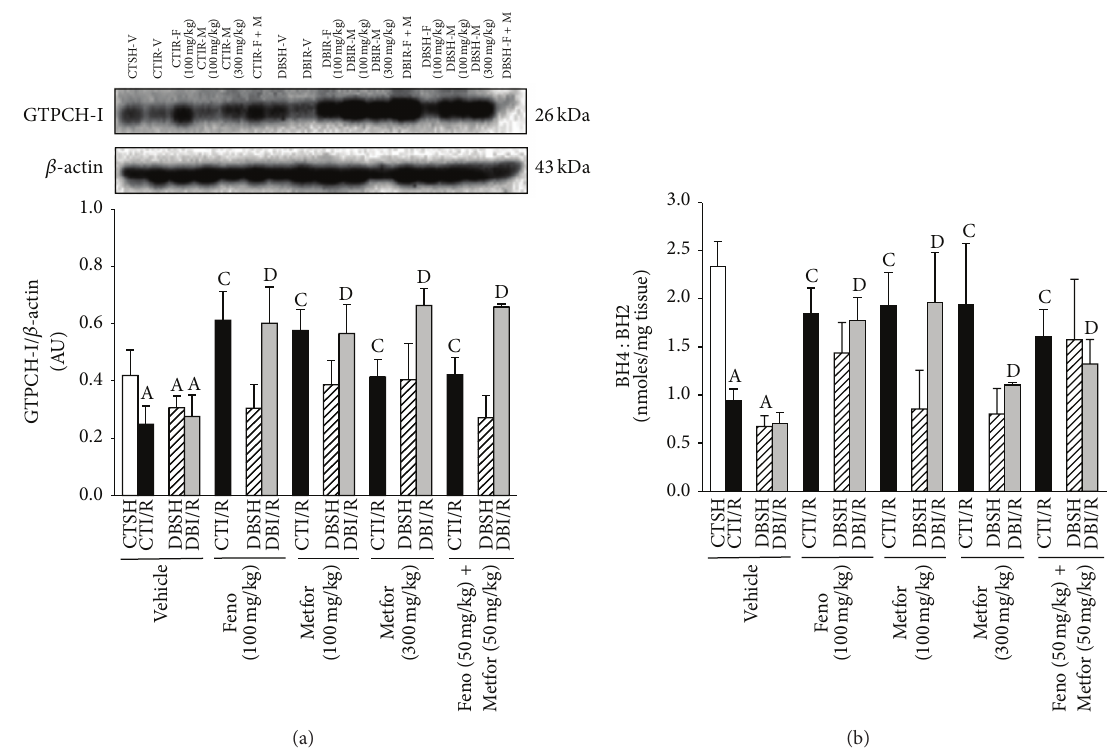
Figure 8: Subchronic treatment with fenofibrate (F), metformin (M), and their combination increases GTPCH-I expression and BH 4 :BH 2 ratio in both control- (CT-) and diabetic- (DB-) rats subjected to ischemia/reperfusion (I/R). GTPCH-I expression was evaluated in ischemic left ventricle area from CT- and DB-rats subjected to sham- (SH-) or I/R-myocardial infarction and treated subchronically (14d) with either vehicle,fenofibrate(F,100 mg/kg),metformin(M,100or300 mg/kg),orFeno(50 mg/kg)+Metfor(50 mg/kg).(a)Representativeimmunoblot and GTPCH-I expression ( 𝑛 = 4 rats/group) and (b) BH 4 :BH 2 ratio ( 𝑛 = 4 –6 rats/group). A 𝑃 < 0.05 versus CTSH-Vehicle, C 𝑃 < 0.05 versus CTI/R-Vehicle, and D 𝑃 < 0.05 versus DBI/R-Vehicle two-way ANOVA followed by Duncan’s post hoc test. Data are presented as means ±